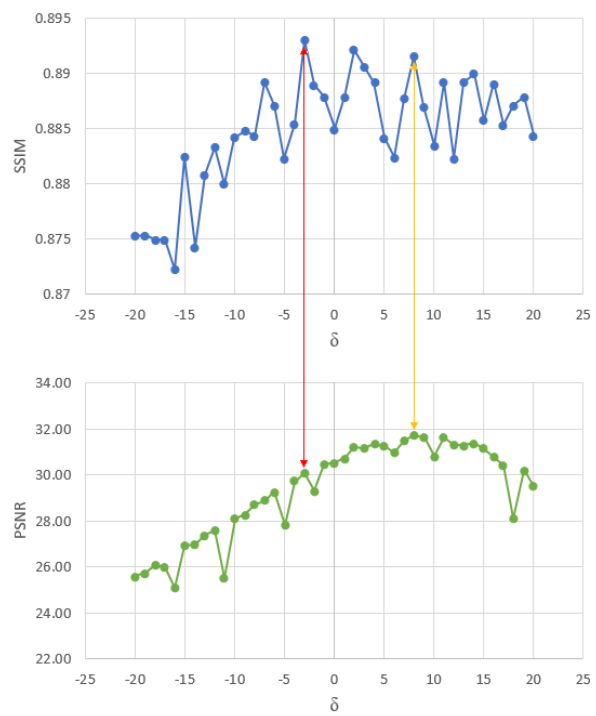
Figure 4. Summary of the tests performed to numerically establish the best value of the parameter δ for controlling the global influence of the atoms. The red arrow points out the maximum SSIM (blue curve) and its corresponding PSNR (green curve). The yellow arrow points out the maximum PSNR and its corresponding